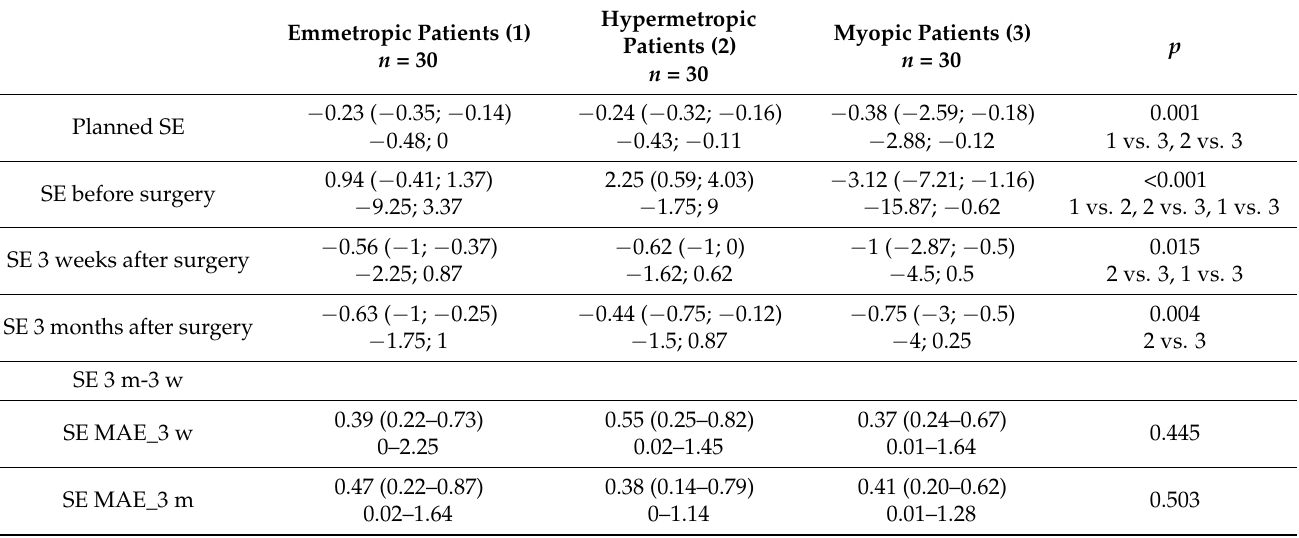
Table 3. Table 3. The SE value characteristics of the analysed groups.